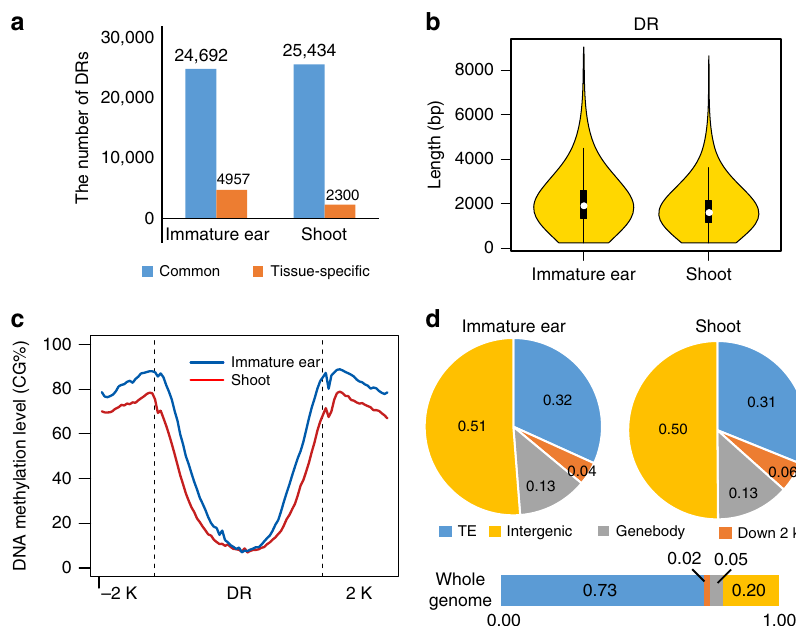
Fig. 2 Identi fi cation of distal regulatory regions (DRs) in immature ear and shoot. a The bar plots show the number of common and tissue-speci fi c DRs in immature ear and shoot. b Violin plots for length of DRs in immature ear and shoot. c The pro fi le of DNA methylation (CG context) around DR in immature ear and shoot. The DNA methylation level 22,23 (CG context) of DRs was signi fi cantly lower than that of their fl anking regions. d The distribution of DRs in different genomic regions in two